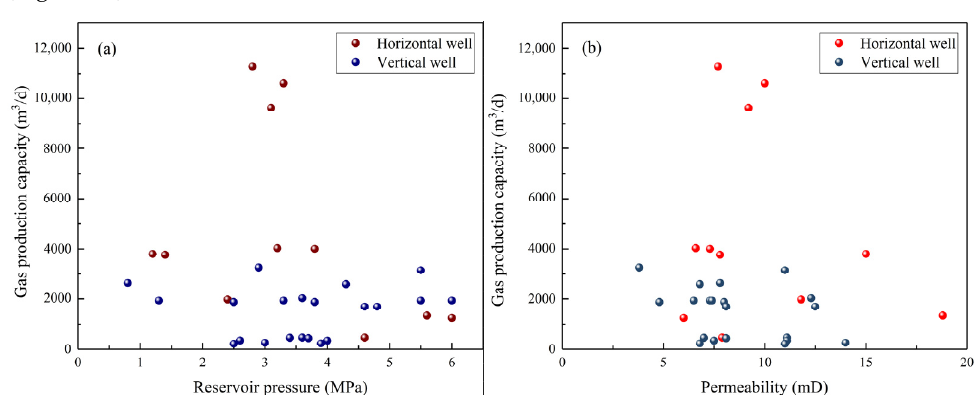
Figure 10. The relationship between gas production and reservoir pressure, permeability: ( a ) reservoir pressure; ( b ) permeability.